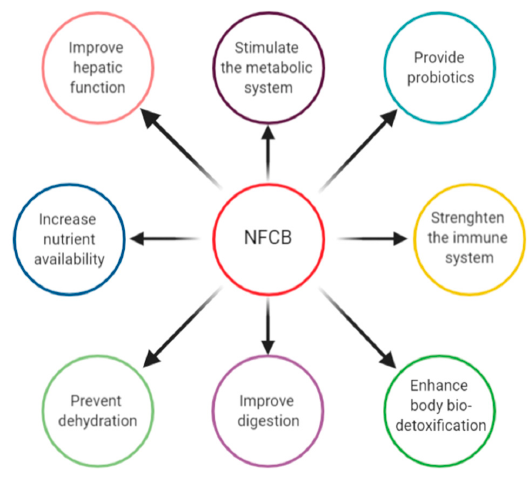
Figure 3. Health benefits associated with NFCB consumption.